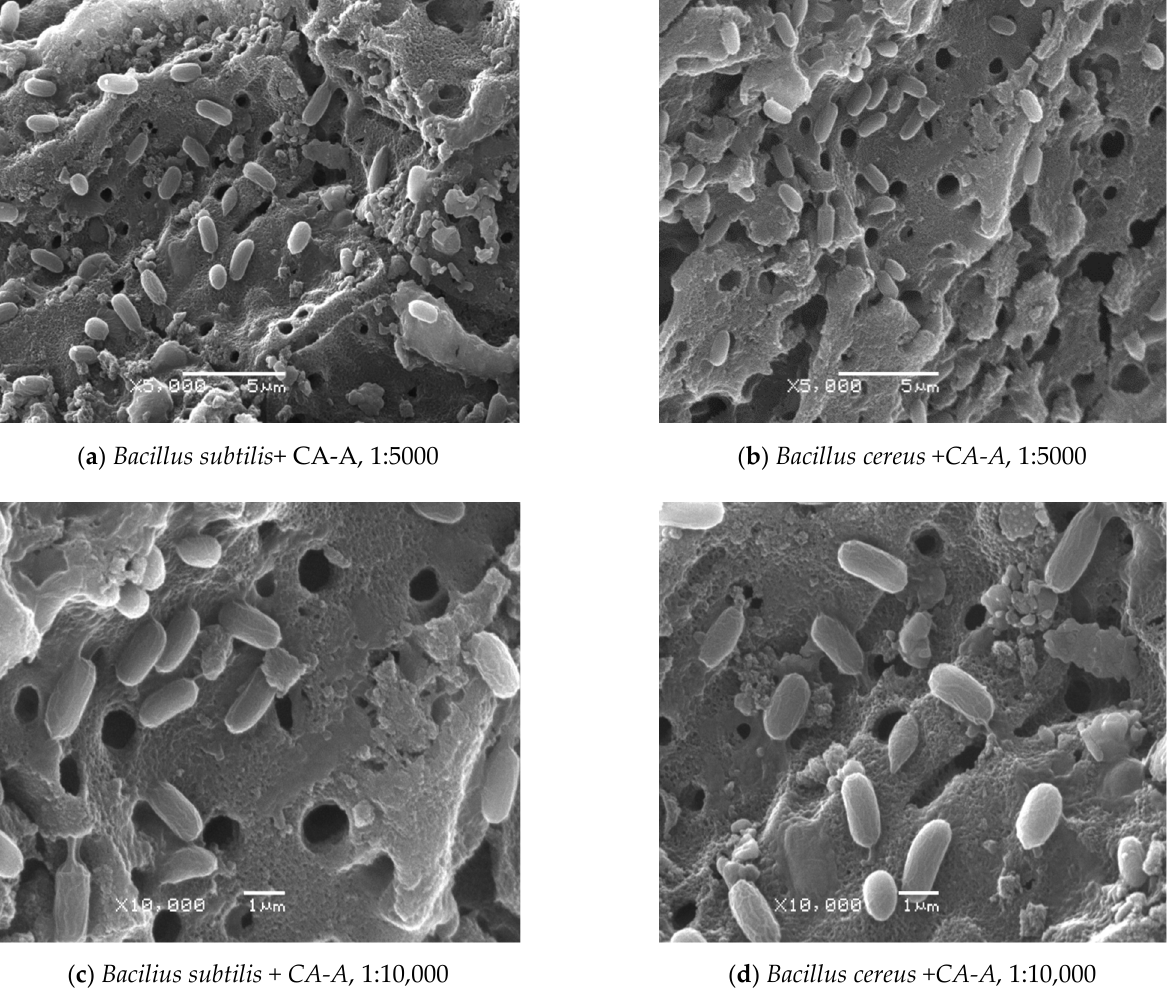
Figure 5. SEM images of the bacteria Bacillus subtilis and Bacillus cereus adsorbed on the enterosorbent CA-A at different magnification scales.